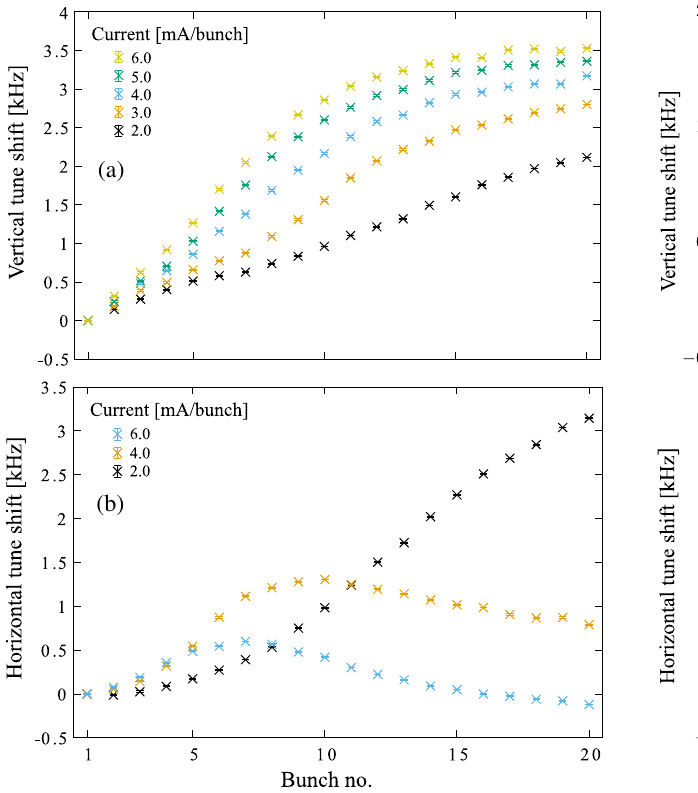
FIG. 3. Tune shifts measured in the (a) vertical and (b) hori- zontal planes using the tune tracker for a 30-bunch train of positrons at 0.4 and 0 . 7 mA = bunch ( 0 . 64 × 10 10 and 1 . 12 × 10 10 bunch populations) at 2.1